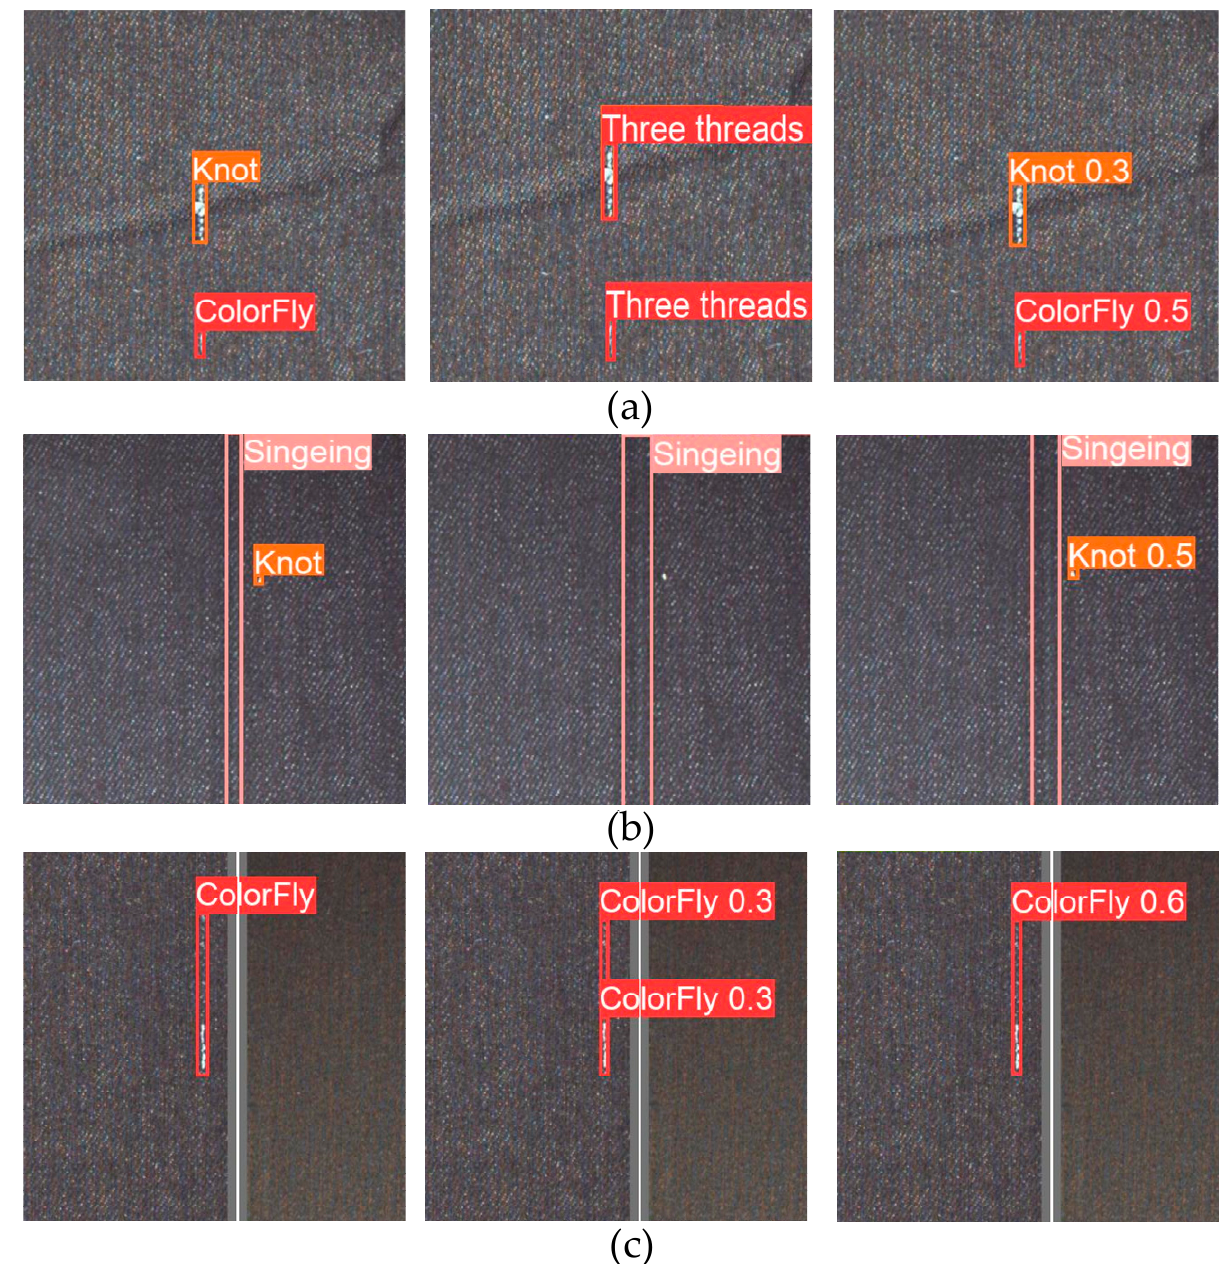
Figure 14. Some visual detection results. The first picture on the left is the labeled picture, the middle picture is the detection result of the original YOLOv5 algorithm, and the picture on the right is the detection result of the improved algorithm: ( a ) Detection result of the similar appearance of two kinds of fabric defects; ( b ) detection result of small target size defects; ( c ) detection result of overlapping fabric defects.